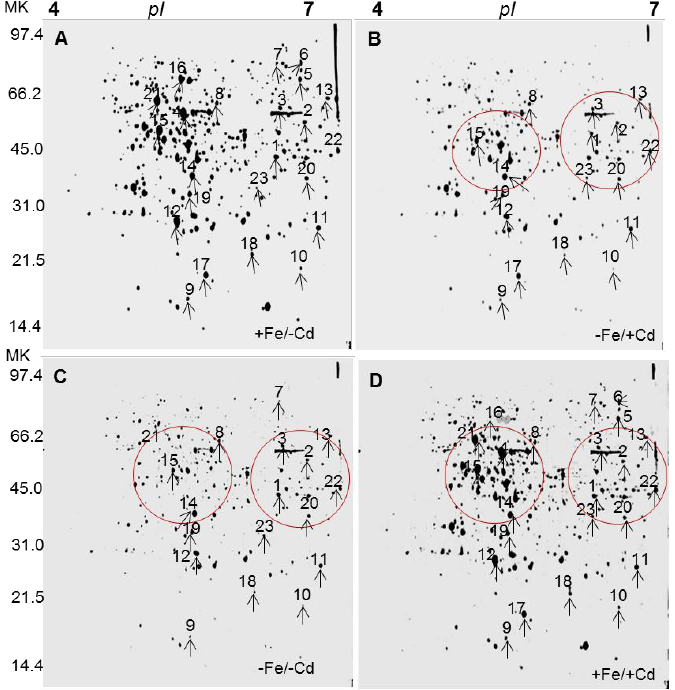
Figure 1. 2D reference images of four Fe/Cd combined treatments: ( A ) Sufficient in iron and no cadmium (+Fe/−Cd, control); ( B ) Deprived iron and cadmium toxicity (−Fe/+Cd); ( C ) Deprived iron with no cadmium (+Fe/−Cd); and ( D ) Sufficient iron but cadmium toxicity (+Fe/+Cd) in the roots of Vigna radiata L. Proteins were separated in the first dimension on a nonlinear IPG strip, pH 4–7 and in 2nd dimension on 12% polyacrylamide SDS-gel. Quantitative image represents differentially expressed proteins. Red encircles indicate absence of protein spots with respect to that of control. Black arrows indicate comparison of protein spots to each other identified by